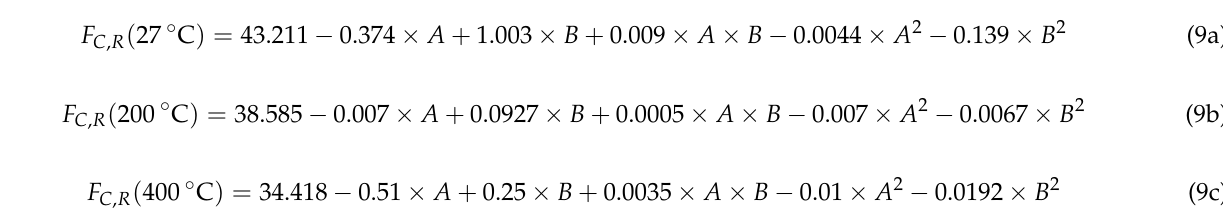
Table 7. ANOVA for elevated temperature models for SCC mixes.